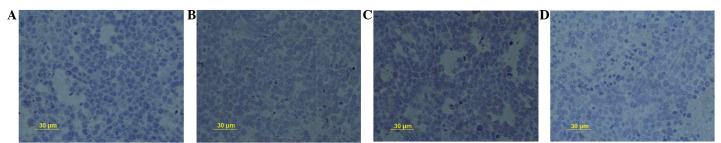
SN50 increases tissue inhibitor of metalloproteinases type-1 (TIMP-1) protein expression. Pathological changes in the SGC7901 tumor cells in (A) the model control and (B–D) experimental groups. (B) 5, (C) 10 and (D) 15 days after treatment with SN50. Hematoxylin and eosin (HE) staining; magnification, x200.